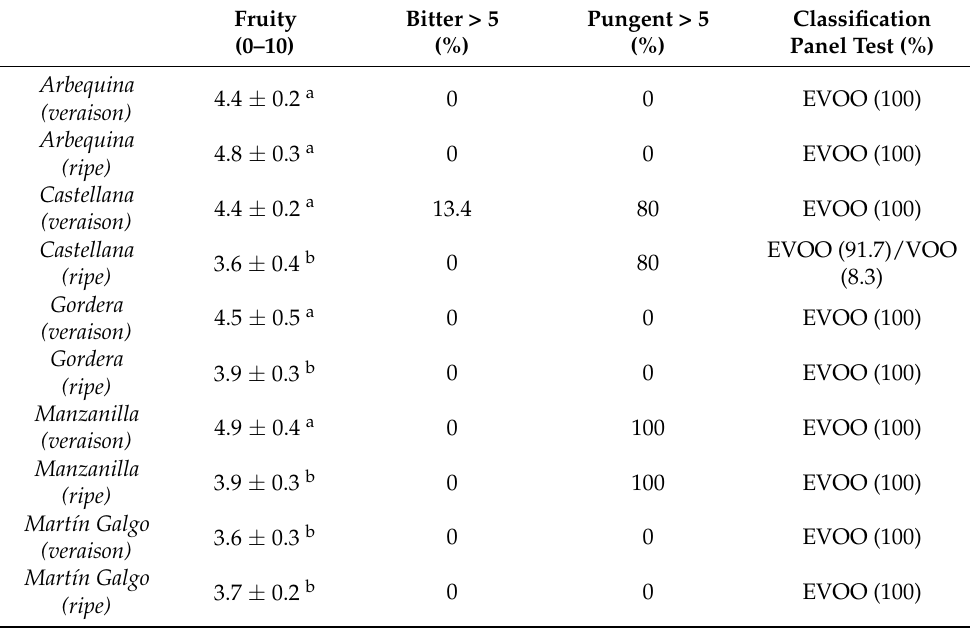
Table 2. Positive sensory attributes and Panel Test classification for the monovarietal oils produced with the variety of olives grown in the Aceite de la Alcarria PDO (veraison and ripe). The values show the means and standard deviations for the samples collected across the four consecutive olive crop seasons under